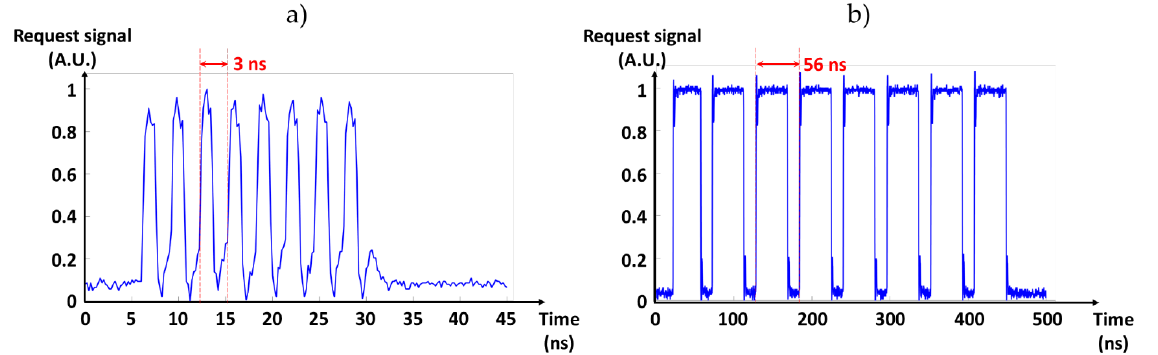
Figure 13. Last FPA request timing measurement. ( a ) Internal acknowledge mode with an output cycle of only 3 ns. ( b ) External acknowledge mode with an output cycle of 56 ns limited by the FPGA operating frequency.